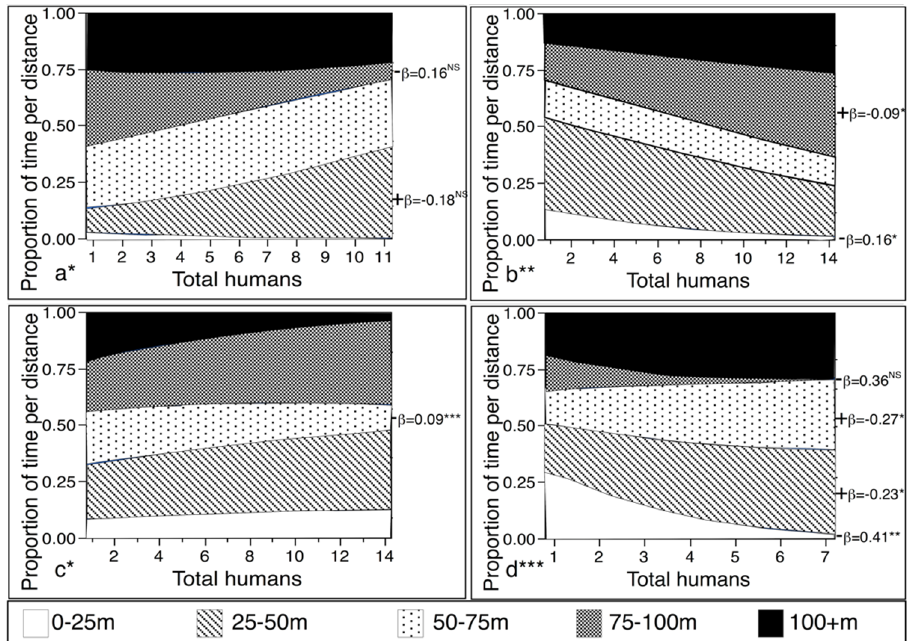
Figure 3. Distance from humans at varying numbers of humans present for ( a ) Group A; ( b ) Group B; ( c ) Group C; and ( d ) Group D. The area between the curves predicts the proportion of time the gibbon spends at each distance. Distances correspond to the key at the bottom of the figure. Individual distances that changed significantly with changing numbers of humans are indicated with either a + (time at distance increases in frequency as number of humans increase) or a − (time at distance decreases in frequency as number of humans increases). For p values, NS: <0.1, *: <0.05, **: <0.01, ***: <0.001.